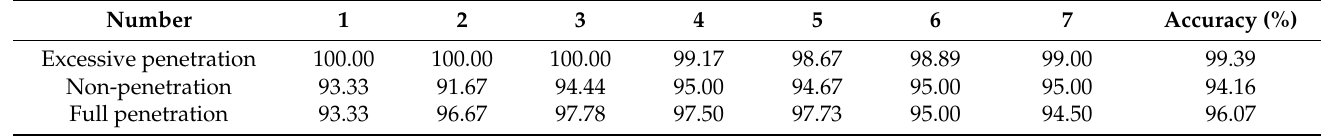
Figure 7. Validation accuracy in three kinds of model.